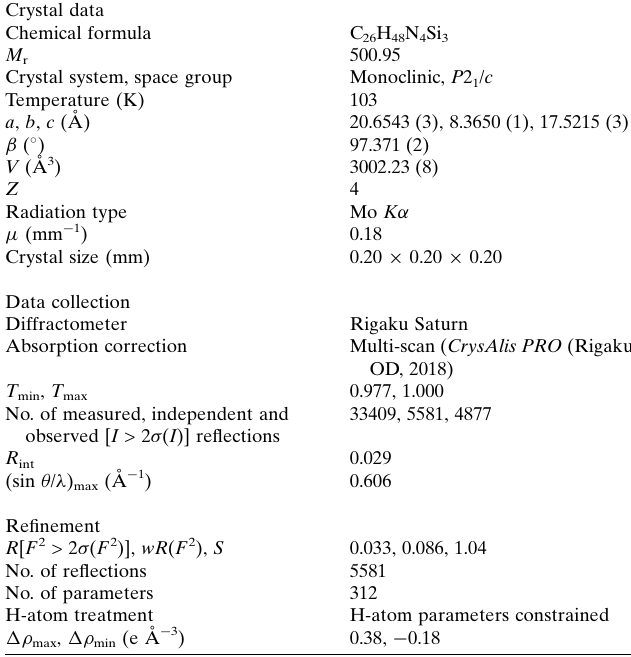
Table 1 Hydrogen-bond geometry (A˚ , (cid:2) ).